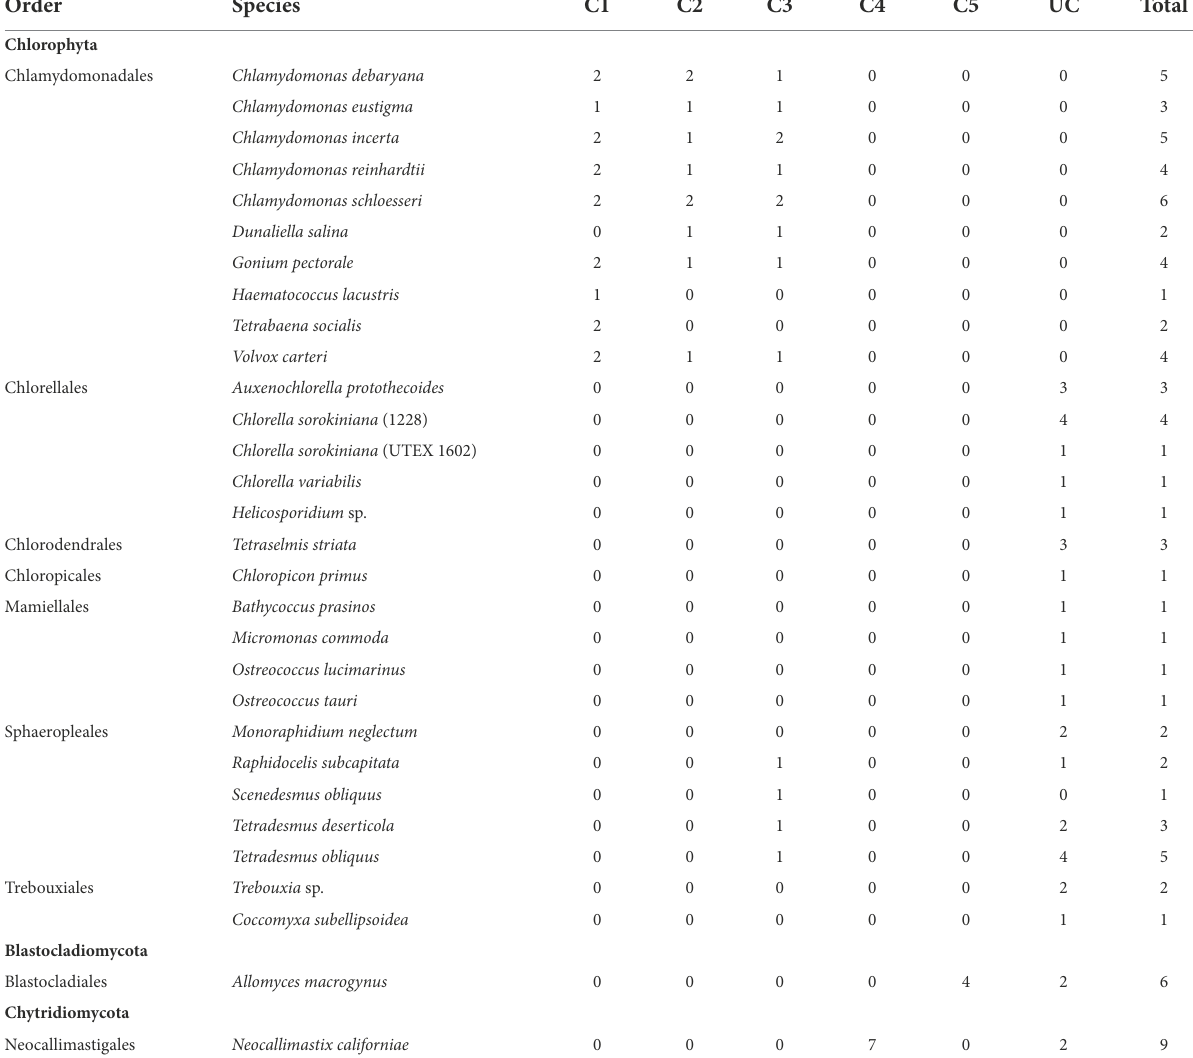
TABLE 1 Numbers and distribution of algae (Chlorophyta) and selected fungi (Blastocladiomycota and Chytridiomycota) SWEET proteins.